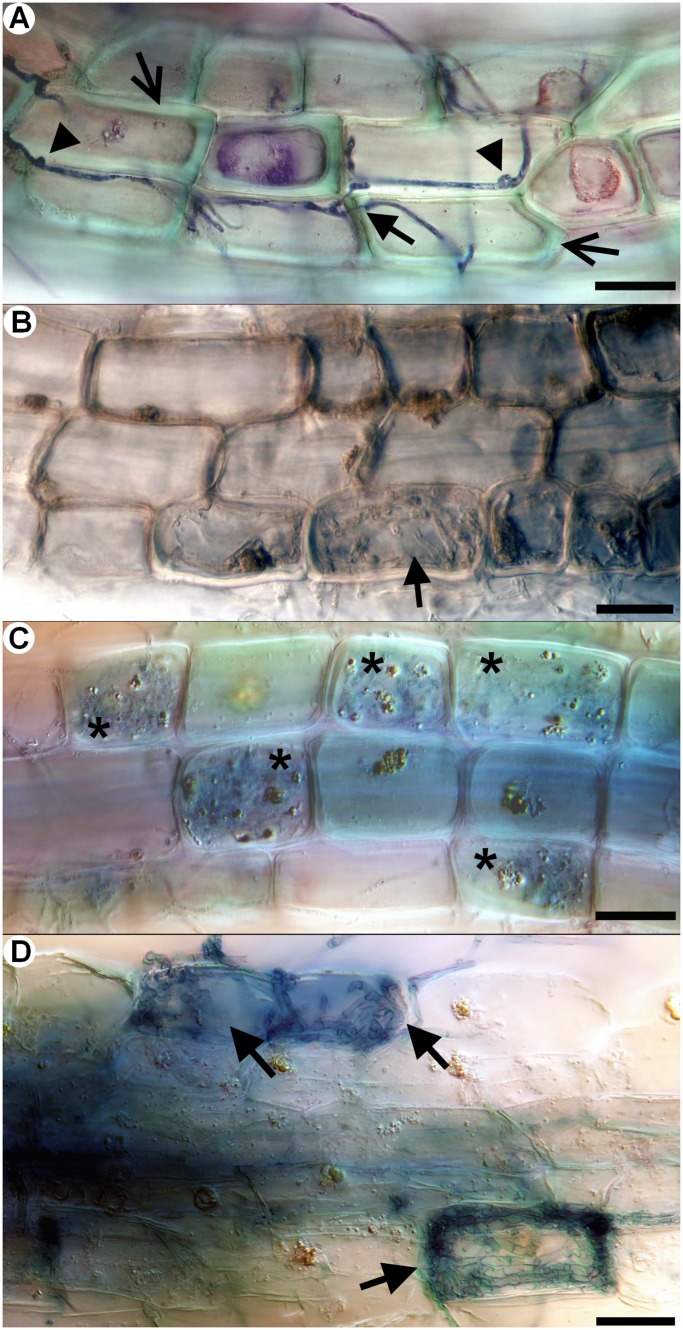

In vitro resynthesis between European blueberry (Vaccinium myrtillus) and saprotrophic, ericoid mycorrhizal and ectomycorrhizal fungi.Saprotrophic Galerina sp. JPK 77, ericoid mycorrhizal Rhizoscyphus ericae RER-2 and ectomycorrhizal Hebeloma bryogenes HBR-1 were used in the resynthesis test. The hair roots were stained with trypan blue (except 6b) and observed with DIC. All bars correspond to 20 µm. 4A) Galerina narrow hyphae pass through blueberry rhizodermal cells. Note clamp connections (arrowheads) and thin hyphae (arrow) penetrating thickened host cell walls (open arrows). 4B) Loose hyaline loops (arrow) rarely formed by Galerina in blueberry rhizodermal cells. 4C) Ericoid mycorrhizae (asterisks) formed by the typical ericoid mycorrhizal fungus R. ericae. 4D) Intracellular colonization formed by the ectomycorrhizal fungus H. bryogenes (arrows).